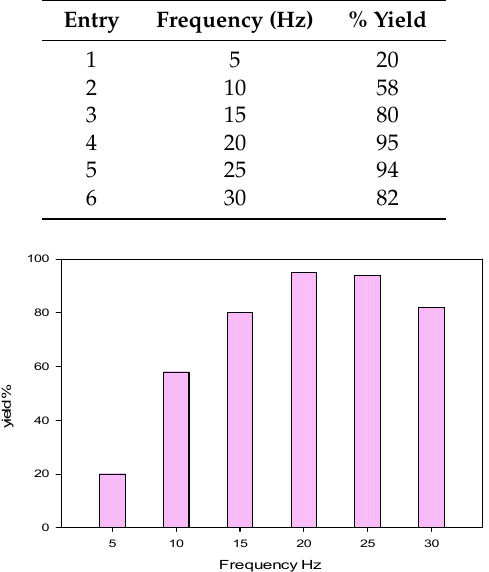
Table 1. Milling of 2.5 g of o -phenylenediamine and 3 g of benzoic acid with 56.6 g of balls for 60 min.